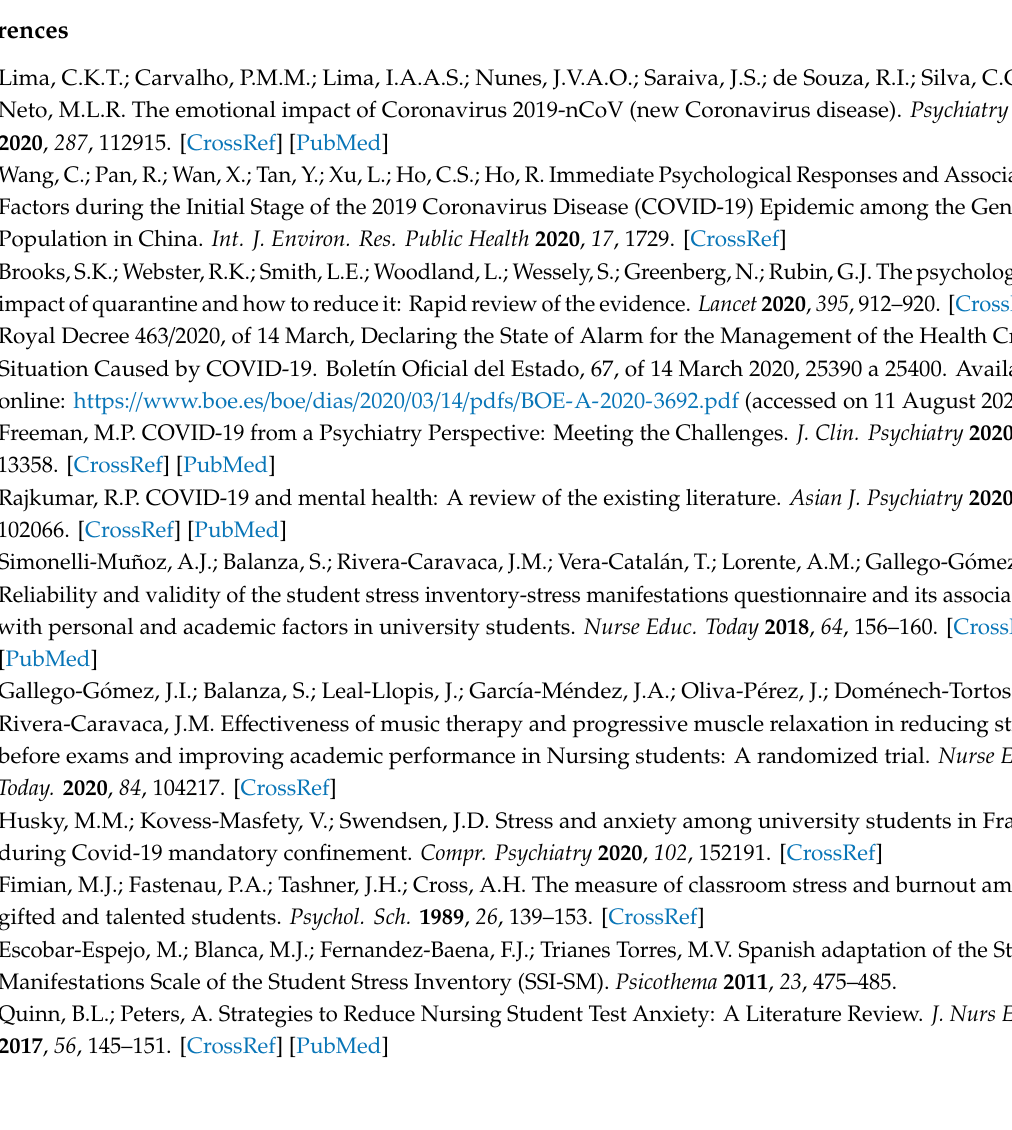
Table S1: Adapted version of the Student Stress Inventory-Stress Manifestations (SSI-SM) for Nursing Students. Author Contributions: Conceptualization, J.I.G.-G., A.J.S.-M. and J.M.R.-C.; methodology, J.I.G.-G., S.B.,